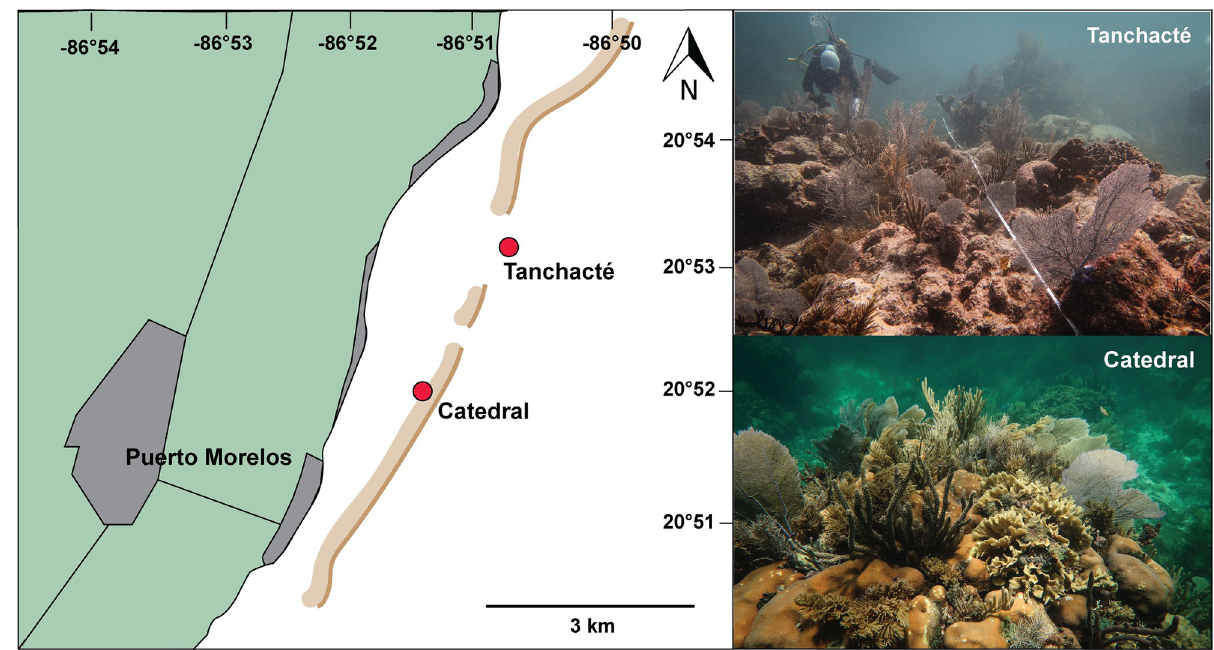
Fig 1. Study sites close to Puerto Morelos, Mexico. The reef crest as visible from satellite imagery is indicated in brown. Catedral is a shallow back reef environment (2 m depth) behind the reef crest and Tanchacte´ a deeper fore reef site (7 m depth) 2.5 km further north.